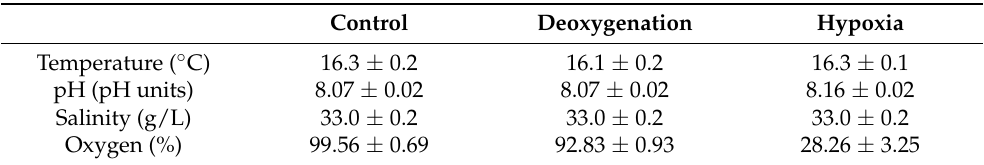
Table 1. Seawater parameters measured during the experiment. Values are represented as means ± standard